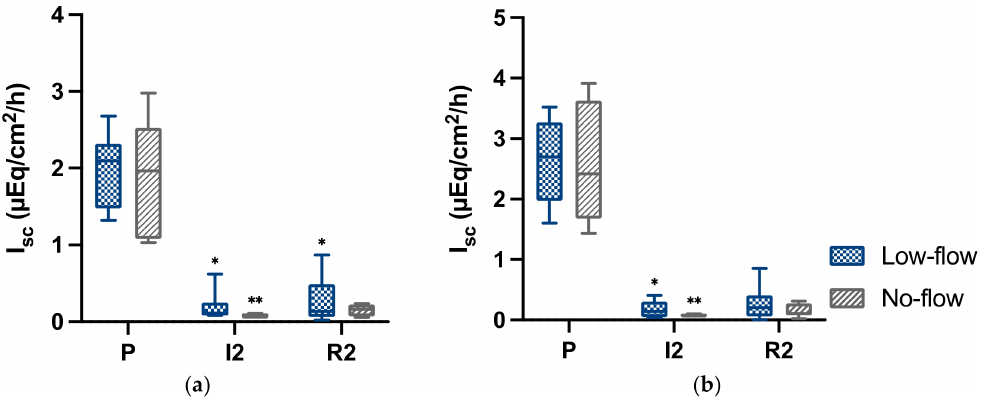
Figure 10. Box-plot diagrams of the short circuit currents (I sc ) following the addition of ( a ) Alanine; or ( b ) Glucose during pre-ischaemia (P), following 120 min of ischaemia (I2) and after 120 min of reperfusion (R2) in horses subjected to low and NF ischaemia. The horizontal bar displays the median, the interquartile range is represented by the box, and the minimum and maximum by the whisker plots. Significant differences of the time points compared to pre-ischaemia are marked with an asterisk (* p < 0.05; ** p <